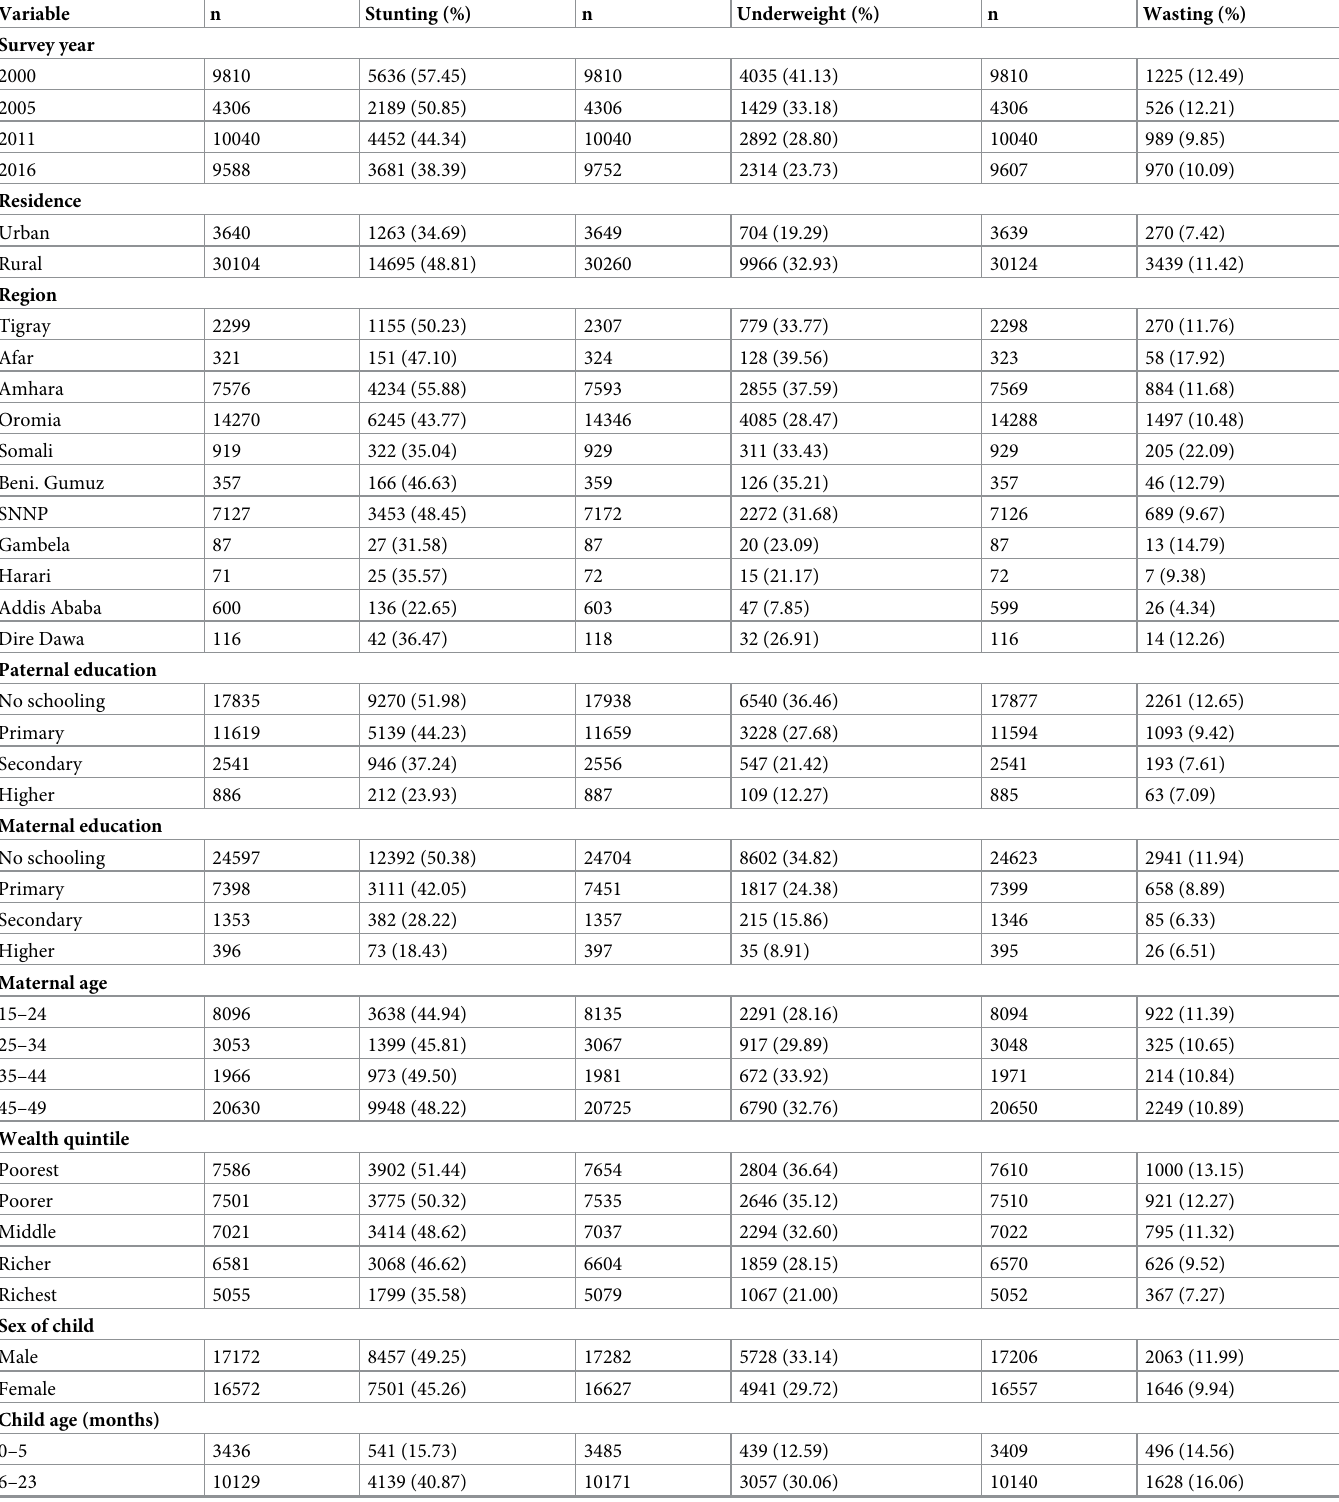
Table 1. Overall prevalence of stunting, underweight and wasting among children aged 0–59 months in Ethiopia, EDHS 2000 to 2016.